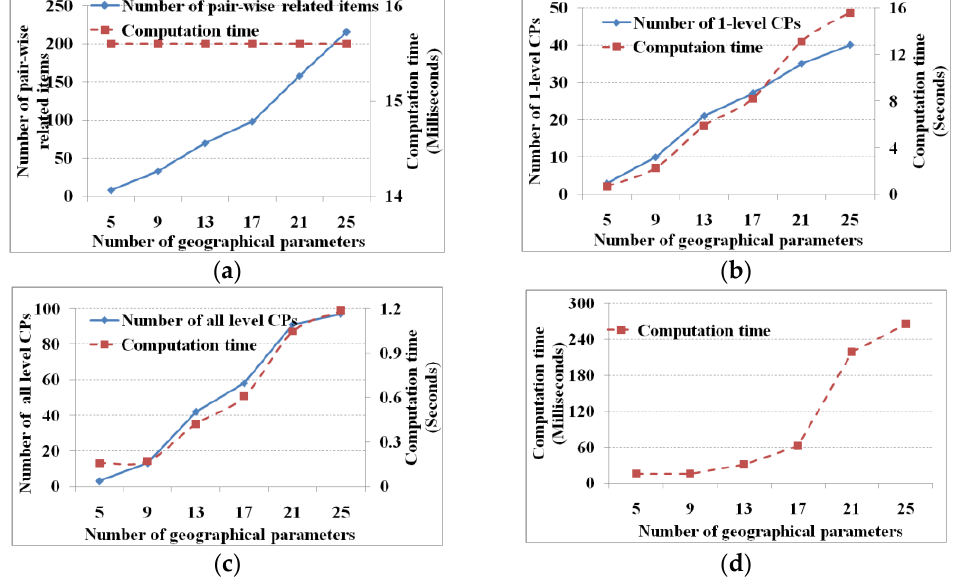
Figure 7. Performance analysis with different field numbers. ( a ) Number of pair-wise related items and computation time; ( b ) Number of one-level cascading patterns and computation time; ( c ) Number of cascading patterns and computation time; ( d ) Linking and pruning computation time.